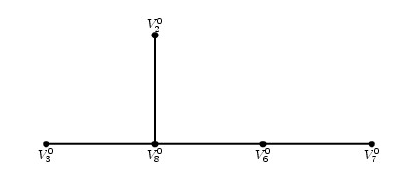
Figure 3. Subgraph of